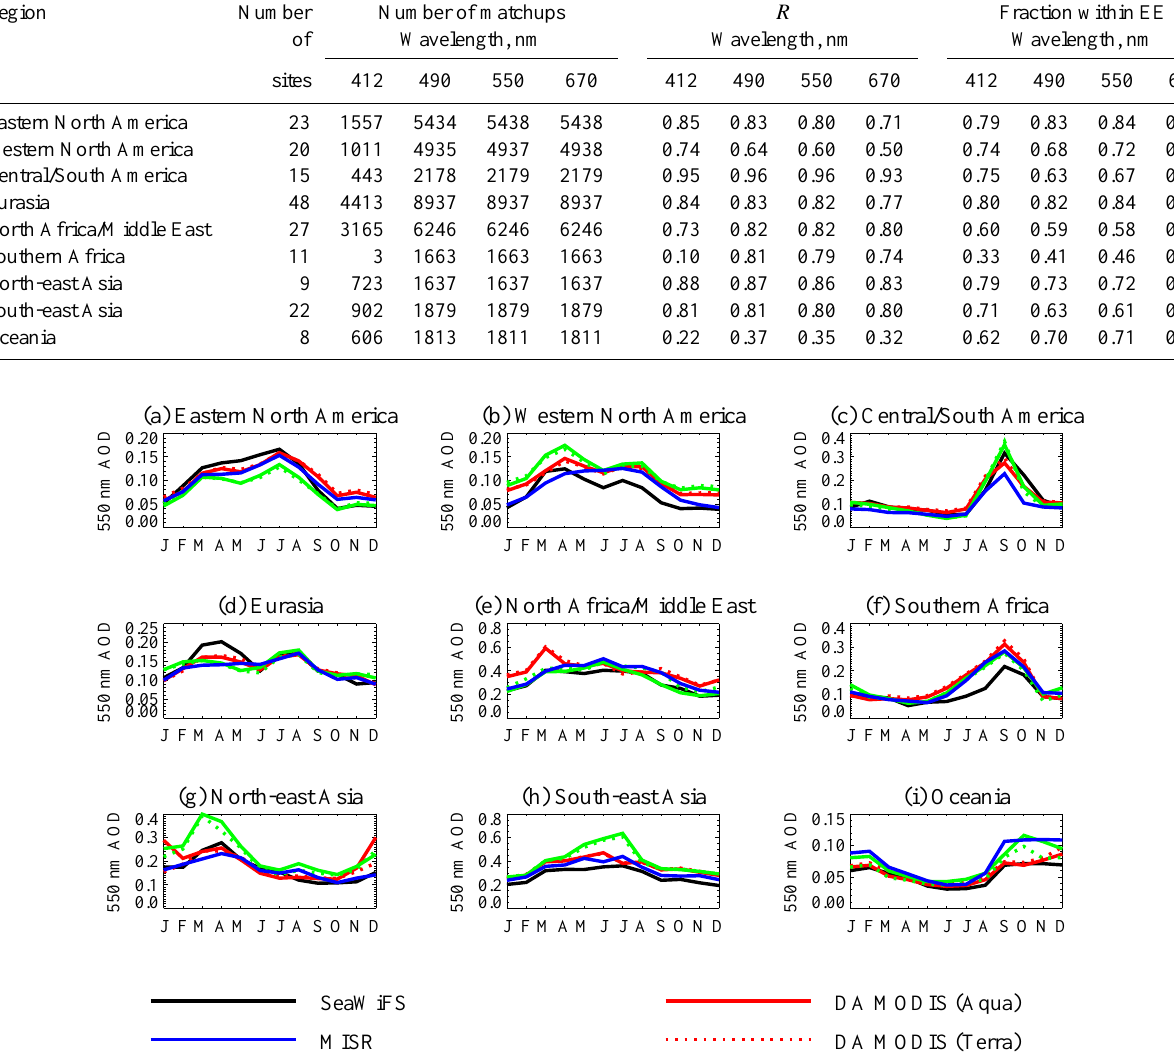
Table 2. Statistics of validation of spectral AOD with AERONET data. Sites are subset according to geographic region (Fig. 1). R is Pearson’s linear correlation coefficient.